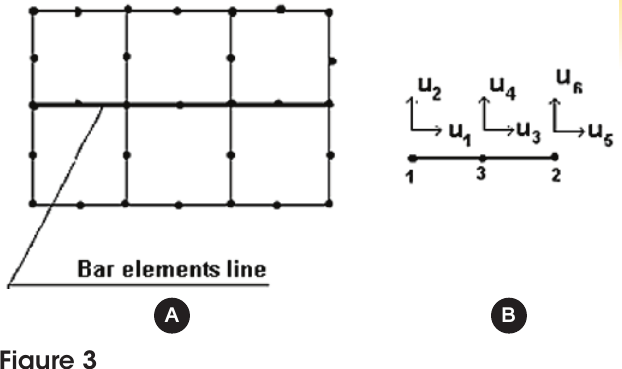
A B Finite elements: a) Plane Q8; b) bar L3